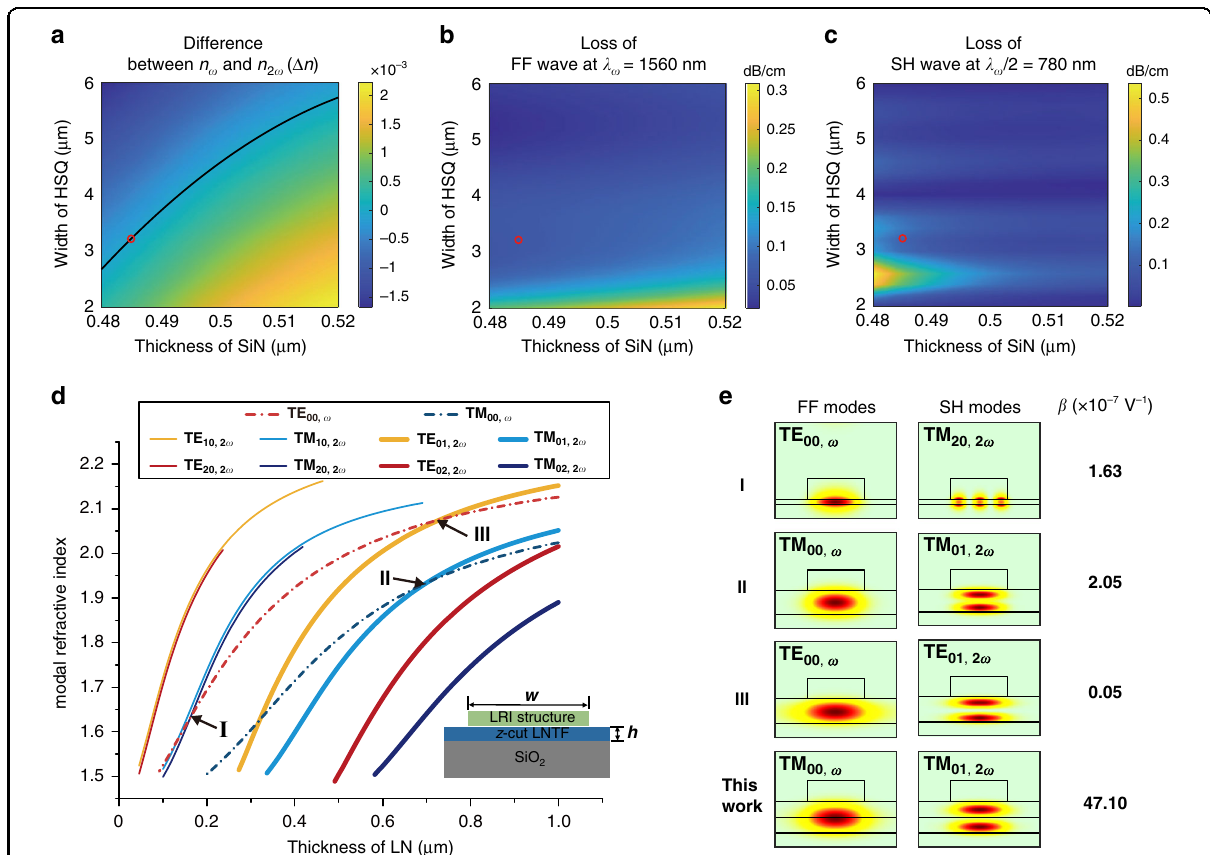
Fig. 2 Numerical optimizations of BIC-based MPM processes for nonlinear interacting waves. a Difference of modal refractive indices ( Δ n ) between the FF TM 00 and SH TM 01 modes as functions of w and t at the pump wavelength of 1560 nm. The black line denotes Δ n ¼ 0, indicating the satisfaction of MPM condition. b , c Corresponding propagation losses dependences on the same parameters in a for the FF TM 00 and SH TM 01 modes, respectively. The red dots in ( a – c ) denotes the chosen parameters in the experiment for nonlinear MPM BICs with small mode sizes and low propagation losses. d Dispersions of the FF and SH waves associated to different orders of modes in a pure etchless LNTF waveguide (inset). The intersection points between the FF modes and SH modes refer to all the possible MPM conditions. e Comparison of the nonlinear mode overlap between our devices and other MPM conditions in a pure LNTF